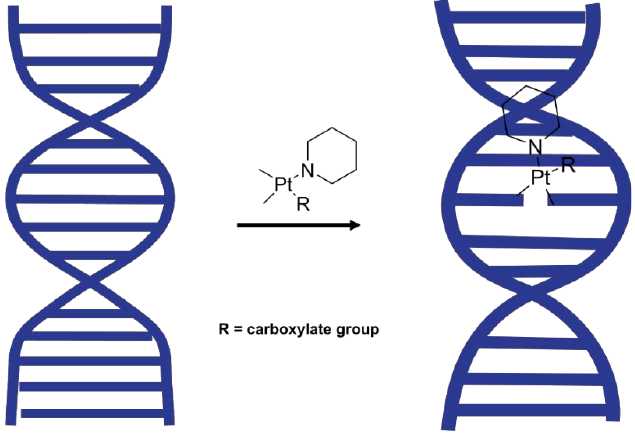
Figure 2. DNA interaction with Pt II and conformation change.